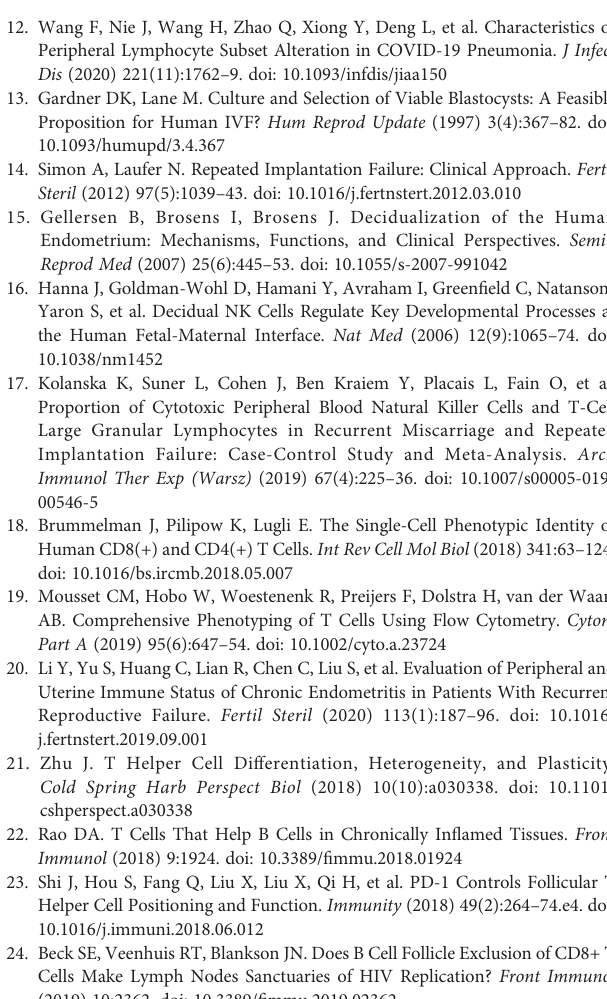
Supplementary Figure 1 | Stepwisegatingprocedureforthe fl